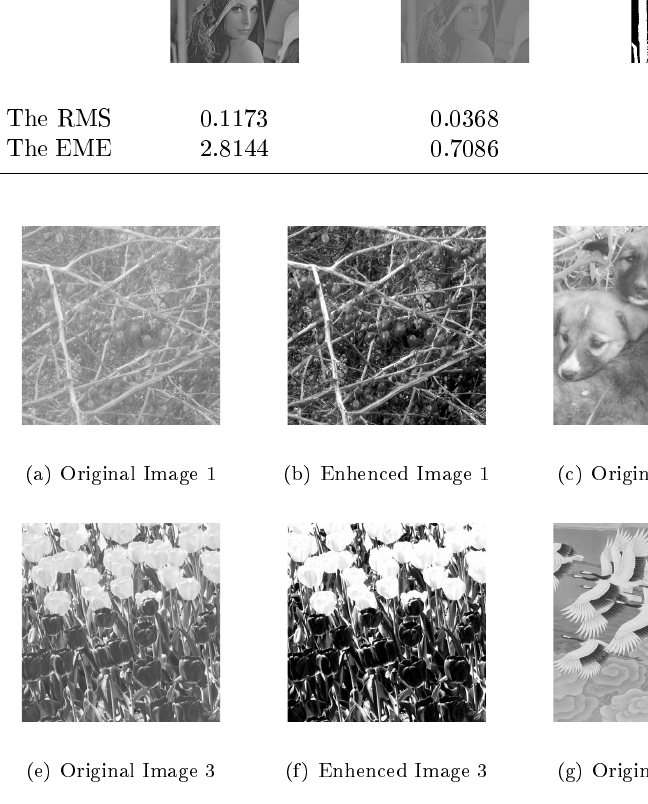
Fig. 4: Experiment